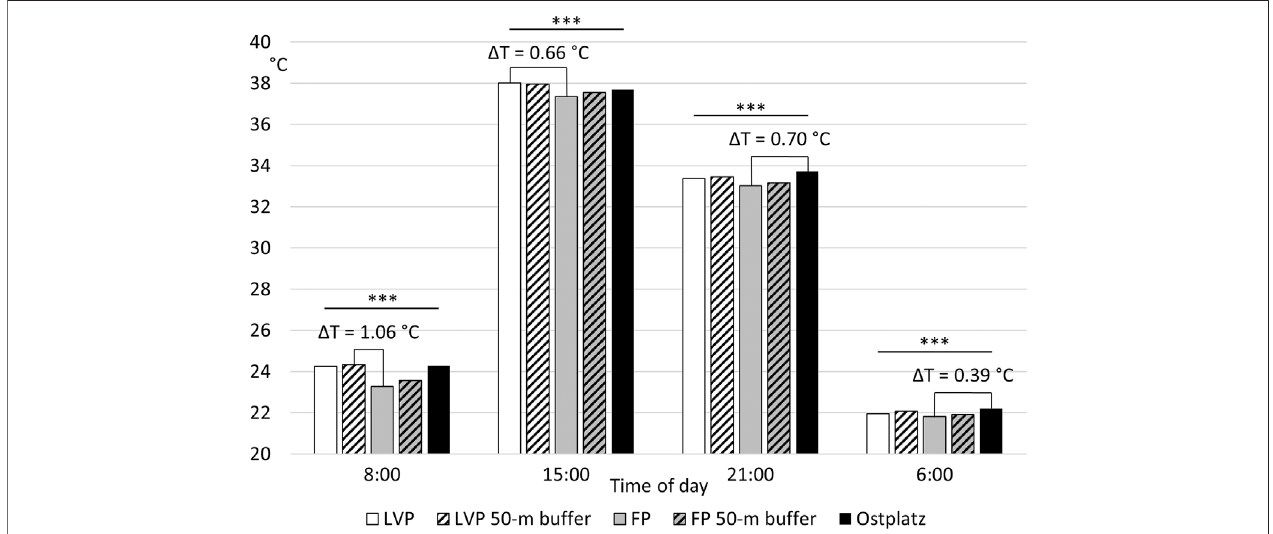
FIGURE6| Meanairtemperaturesofthe fi veanalyticalareas per timeofthedaythathasbeen selectedforspatial assessment. Foreach pointintime weindicated maximumairtemperaturedifferencesoccurringamongall fi veareas.Asterisksabovethebarsindicatethesigni fi cancelevel(ofdifference)betweenallareasaccordingto ANOVA ( p ≤ 0.001, Supplementary Material S4 ). Acronyms: LVP, Lene-Voigt-Park; FP,